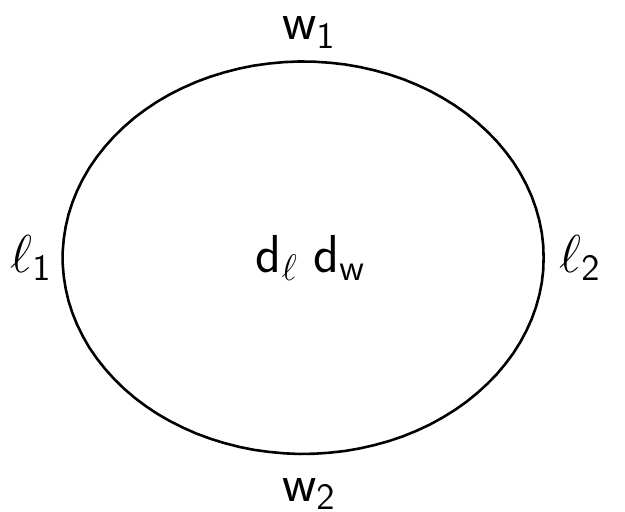
Figure 5. (cid:96) 1 and (cid:96) 2 denote the minimal gray values (GVs) along the major axis indicated in Figure 3 (title “long”) by the position of orange lines. By analogy, denote w 1 and w 2 the minimal GVs along the minor axis. d (cid:96) and d w denote the maxima in the middle along major and minor axes, respectively. To avoid misunderstanding, minimal GVs indicate maximal RBC